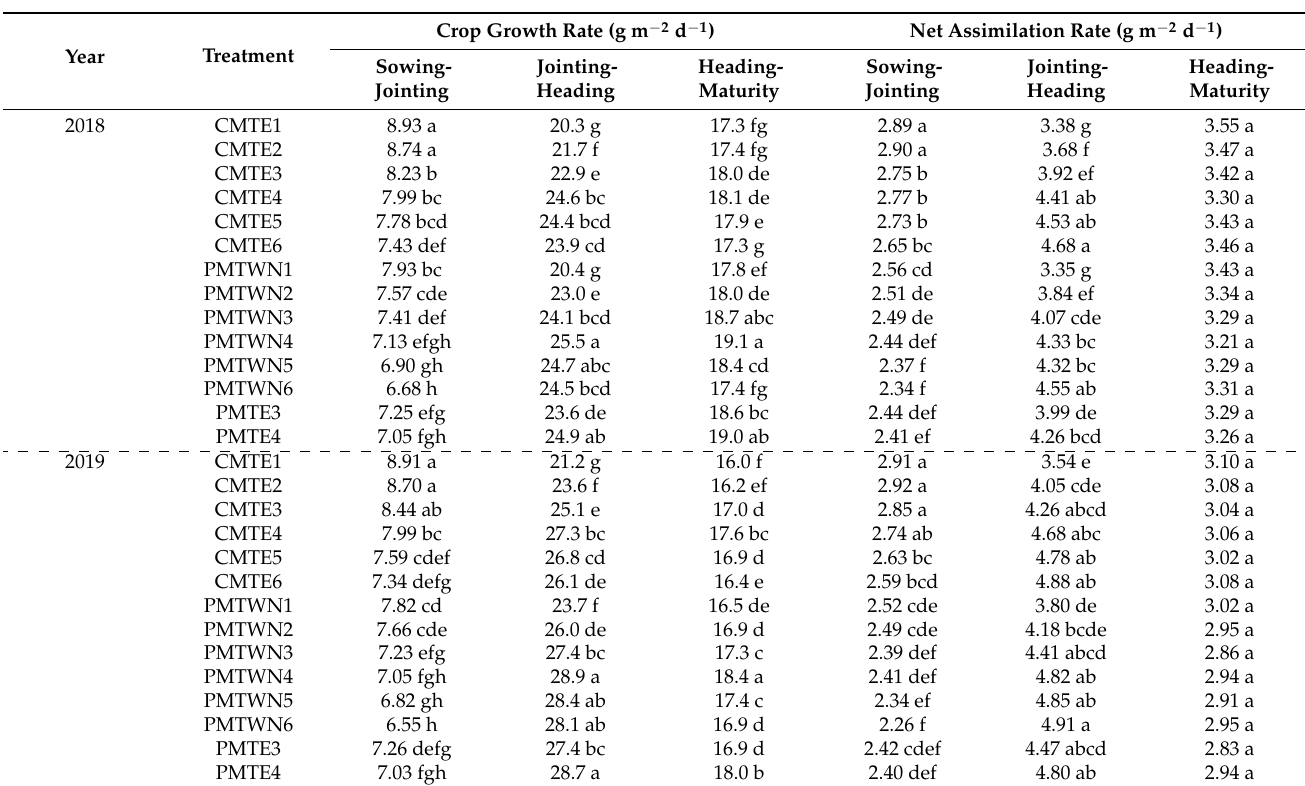
Table 7. The crop growth rate and net assimilation rate of rice under different mechanical transplant- ing methods and planting